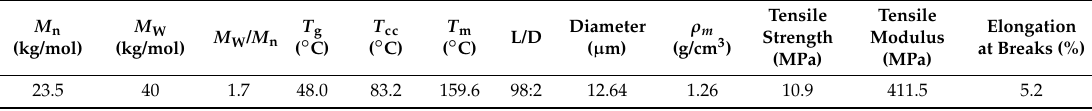
Table 1. Molecular weight and thermo-mechanical properties of PLA